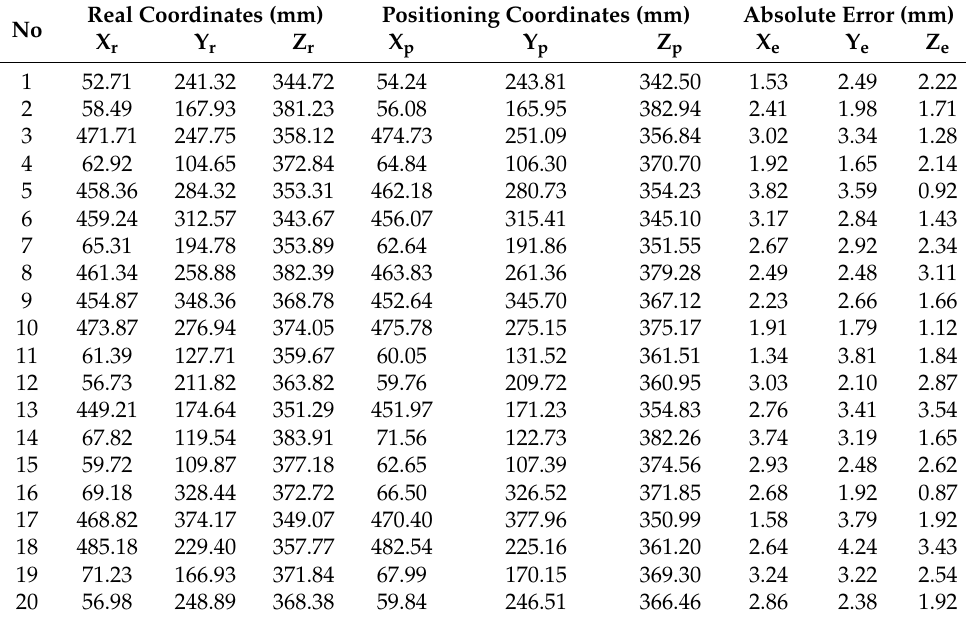
Table 12. The spatial positioning experiment results of YOLOv7.